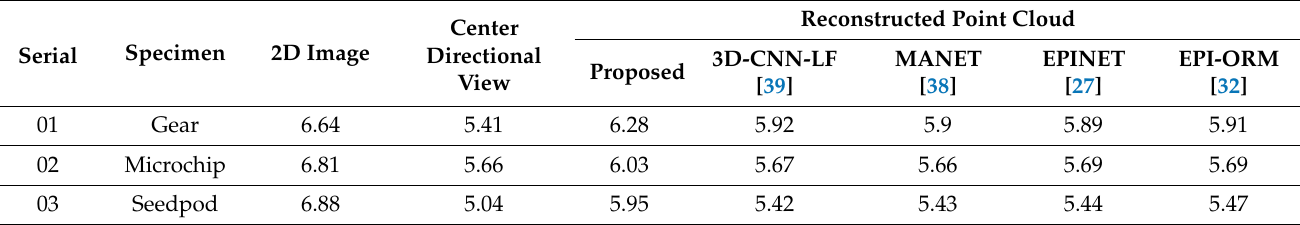
Table 2. Quantitative evaluation with the PSD * value for 3D reconstructed